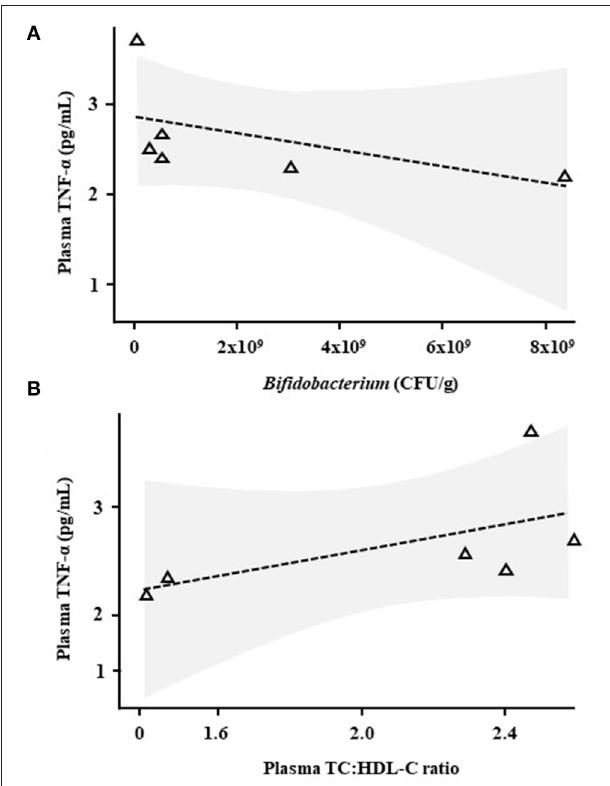
FIGURE 3 | Correlative analysis in Wistar rats after 90 days supplementation with Lab4. Scatter plots between plasma tumour necrosis factor- α (TNF- α ) levels and (A) faecal Bifidobacterium levels or (B) the plasma TC:HDL-C ratio in rats receiving Lab4 for 90 days. Analysis was performed on pairwise data from six rats. TNF, tumour necrosis factor; TC, total cholesterol; HDL-C, high density lipoprotein cholesterol.